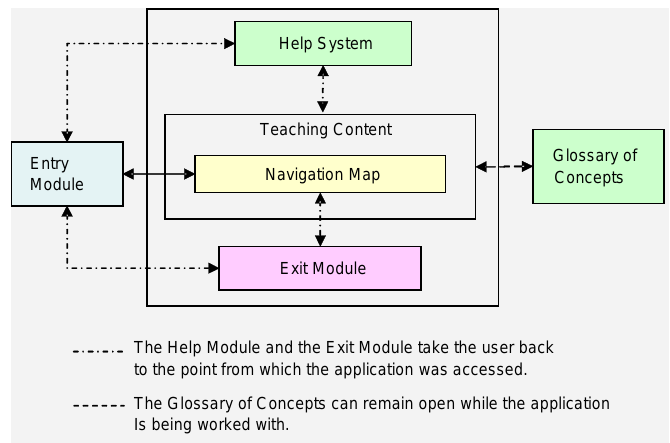
Figure 7. “Diagram of the structure of the